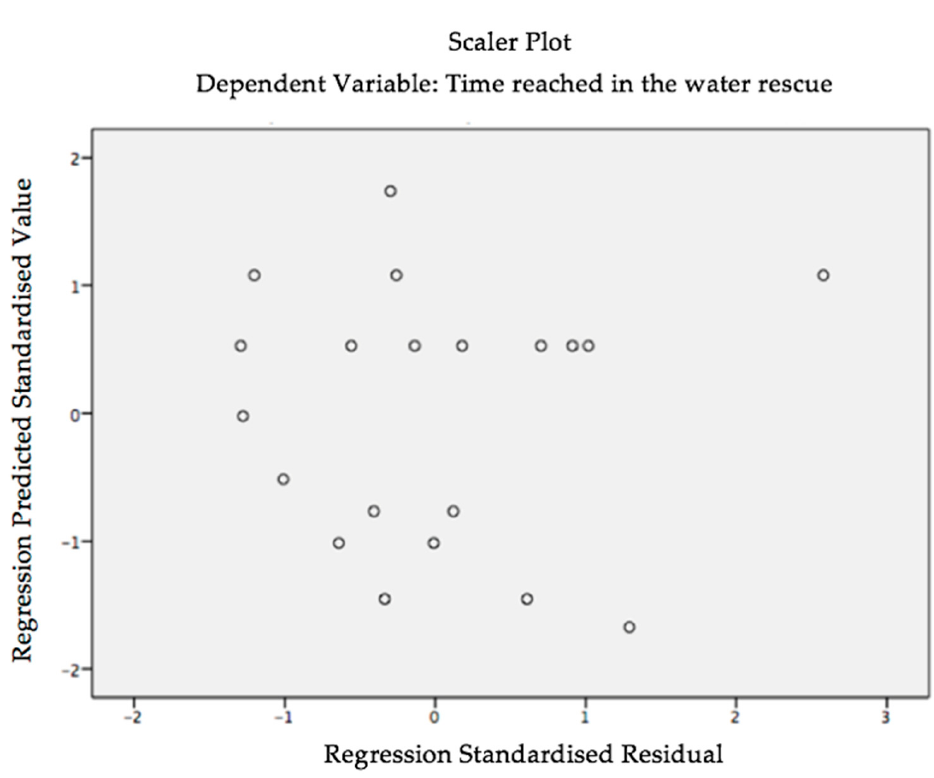
Figure 1. Partial regression between time spent in the rescue (TimeRescue) and time reached in the Incremental Test in Pool for Lifeguards (IPTL) (TimeIPTL).